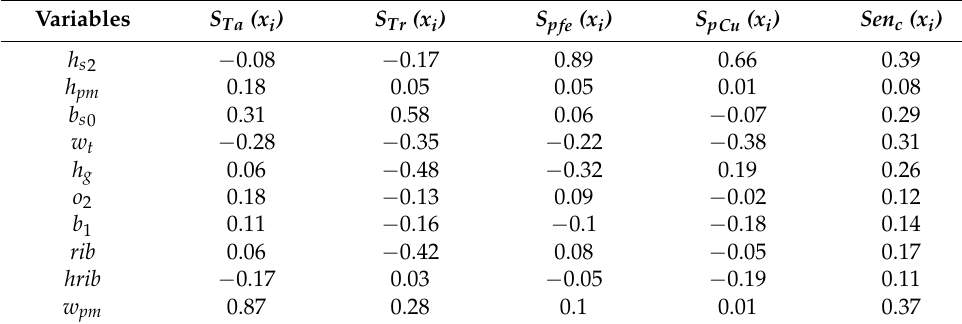
Figure 3. Sensitivity of optimization variables and optimization objectives. Table 3. Comprehensive sensitivity values of optimization